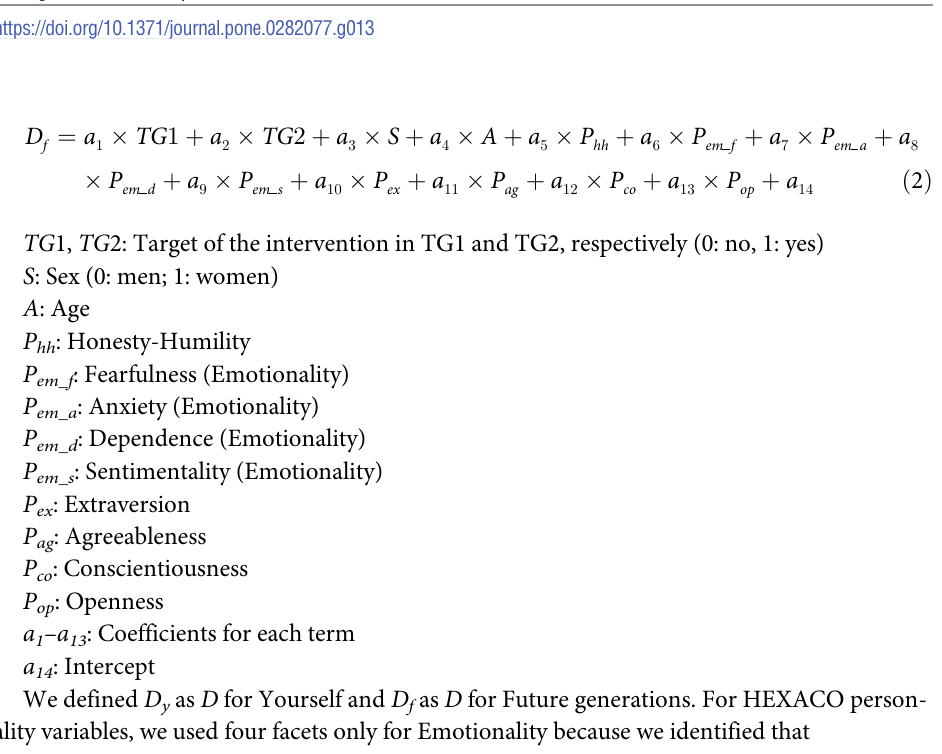
Fig 13. Attitude change toward IT innovations after receiving a designed message ( D ) by age. The value on the vertical axis is higher the less dangerous the perception of IT innovations became. Y, respondents under 50 years old; O, respondents over 50 years old. Error bars show 95% confidence